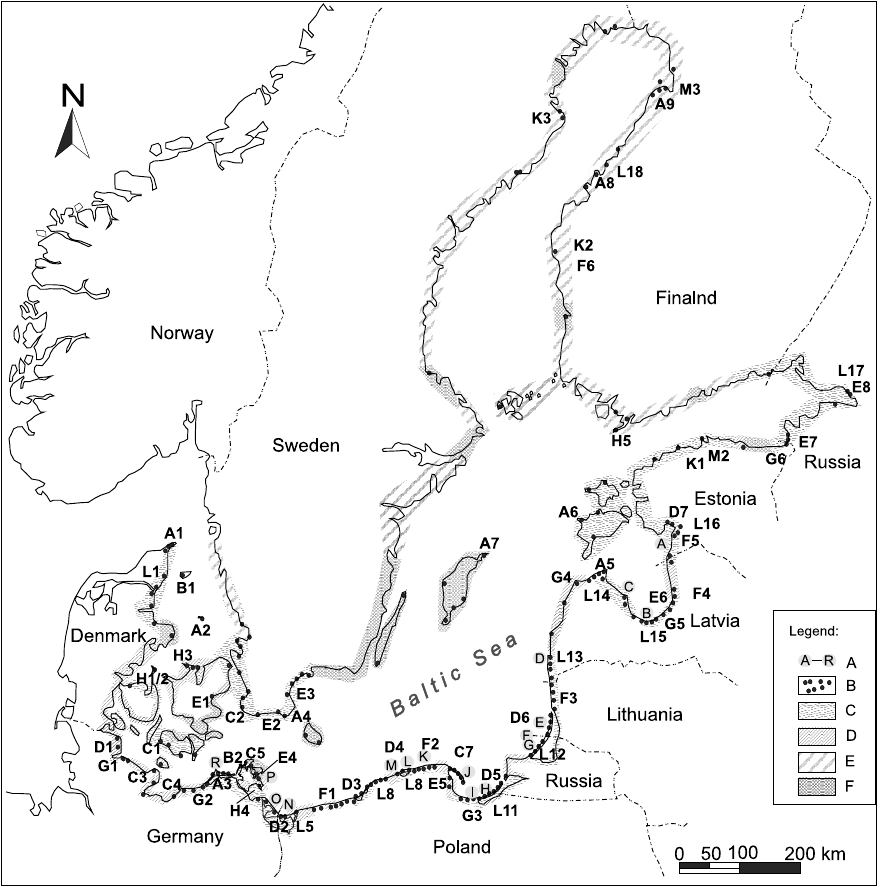
Fig. 1. Location of varied sandy and other coasts around Baltic Sea (based on Łabuz 2015b); letters and digits refer to sandy coast type, see Table